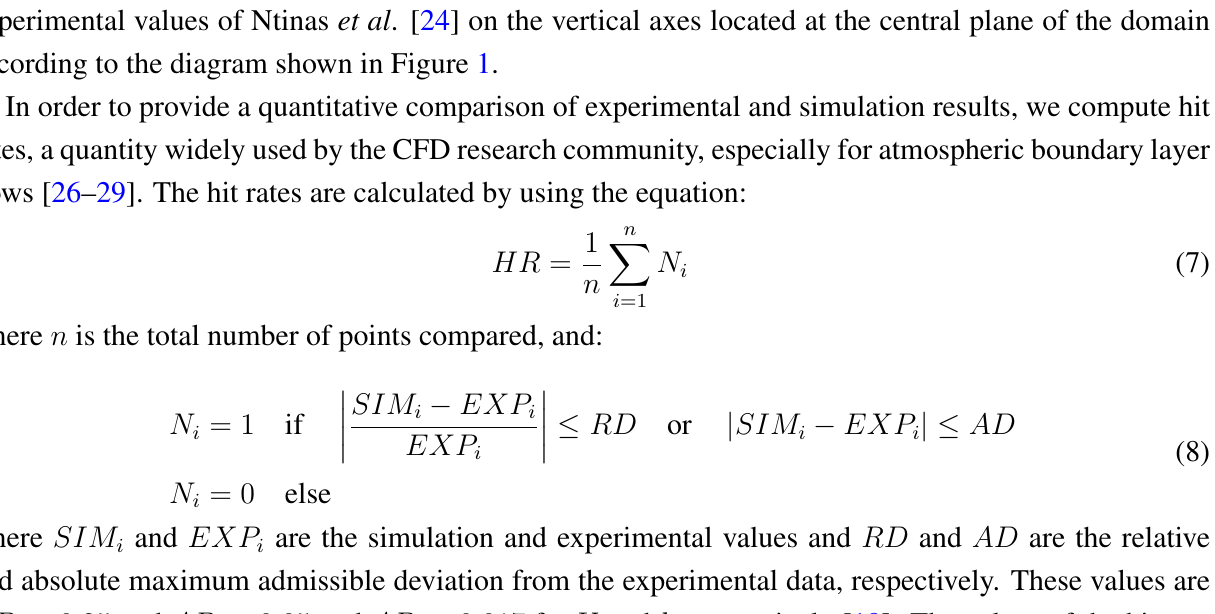
; ( b ) U ; ( c ) U ; ( d ) k V 1 V 2 V 3 V 3